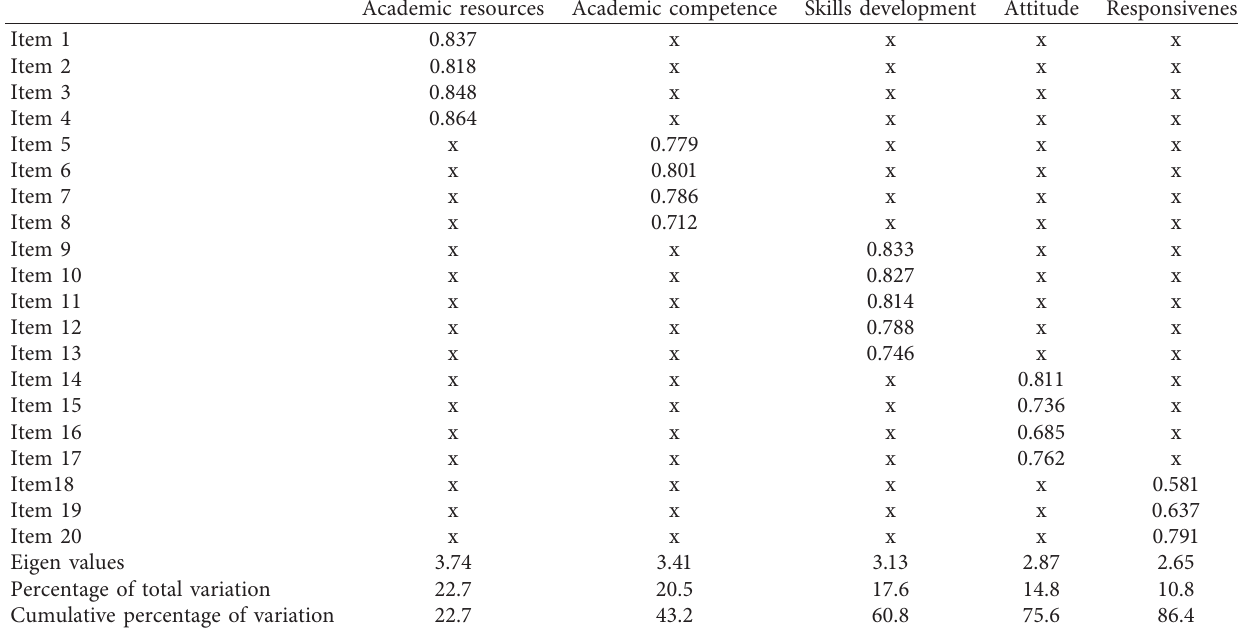
Table 2: Principal component analysis for academic service quality.